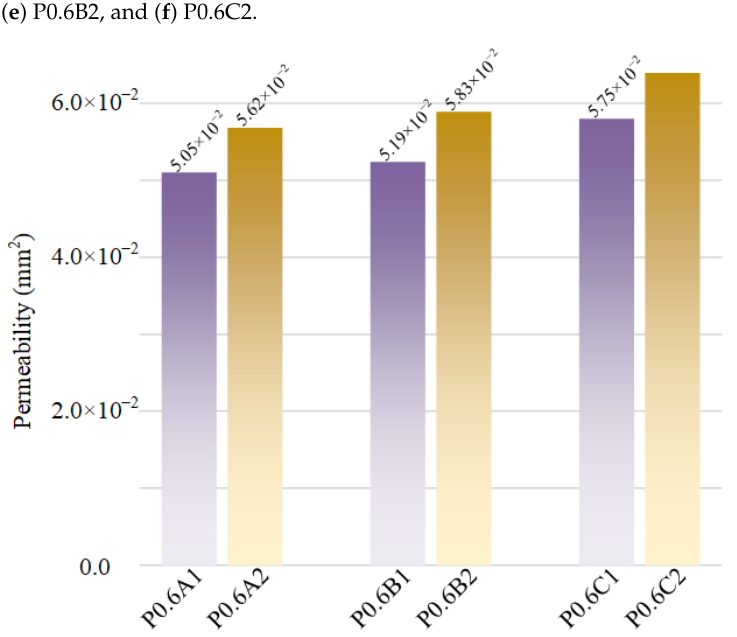
Figure 10. Comparison of the calculated permeability of different P0.6 scaffolds.